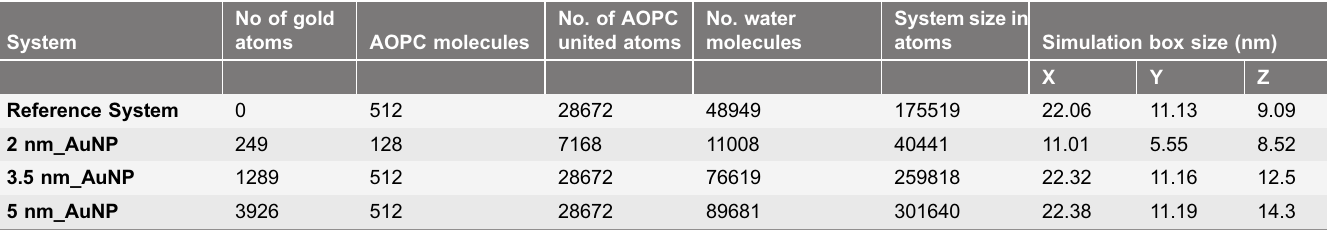
Table 1. Details of the bilayer AuNP